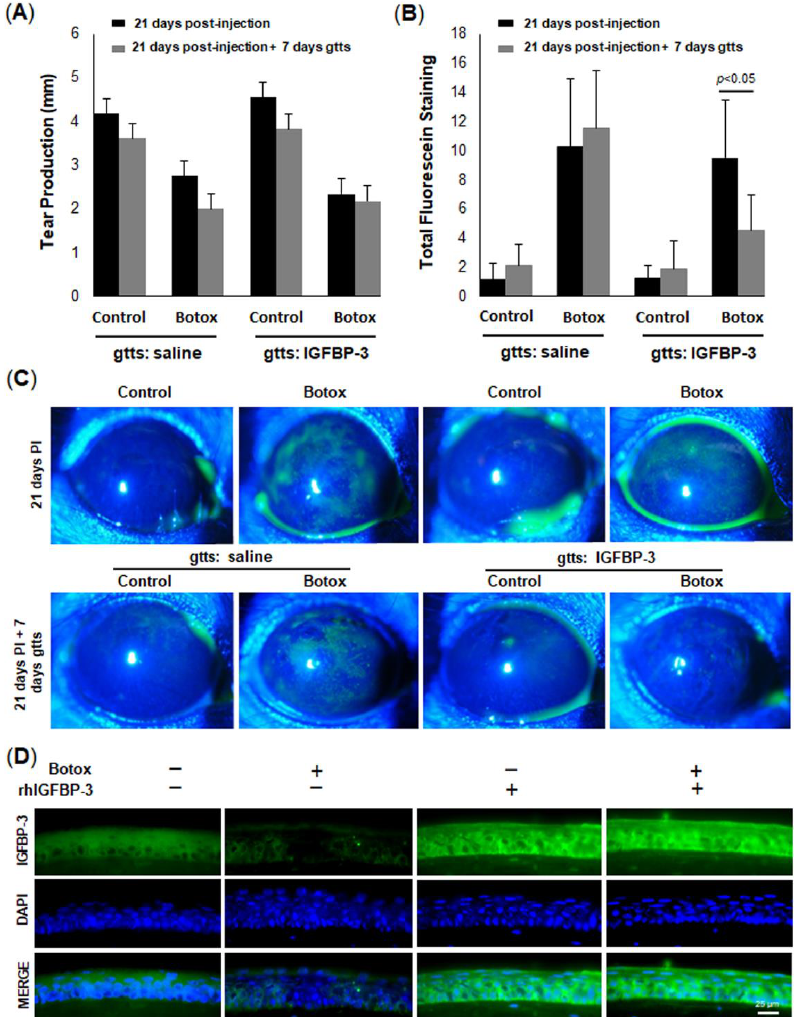
Figure 8. Topical rhIGFBP-3 decreases corneal staining in a mouse with aqueous-deficient DED. The lacrimal gland was injected with botulinum toxin or a vehicle control. After 21 days, mice were treated topically with 10 µ L of sterile saline with or without 500 ng/mL rhIGFBP-3 twice a day every other day for 7 days. ( A ) After seven days of dosing, aqueous tear production by the lacrimal gland was unchanged in the treatment and control groups ( n = 4 mice per group). ( B ) Total corneal staining was decreased in the Botox group treated with rhIGFBP-3 compared to saline ( n = 8 mice per group). ( C ) Representative slit-lamp images of corneal fluorescein staining in mice. ( D ) Immunostaining of corneal cryosections for IGFBP-3 (green) and DAPI (blue). Scale bar: 25 µ m. Graphical data are presented as mean ± standard deviation, one-way ANOVA and SNK multiple comparison test. Slit lamp images representative of 8 mice per group. Immunostaining images representative of 3 mice per group. Gtts: eye drops; PI: